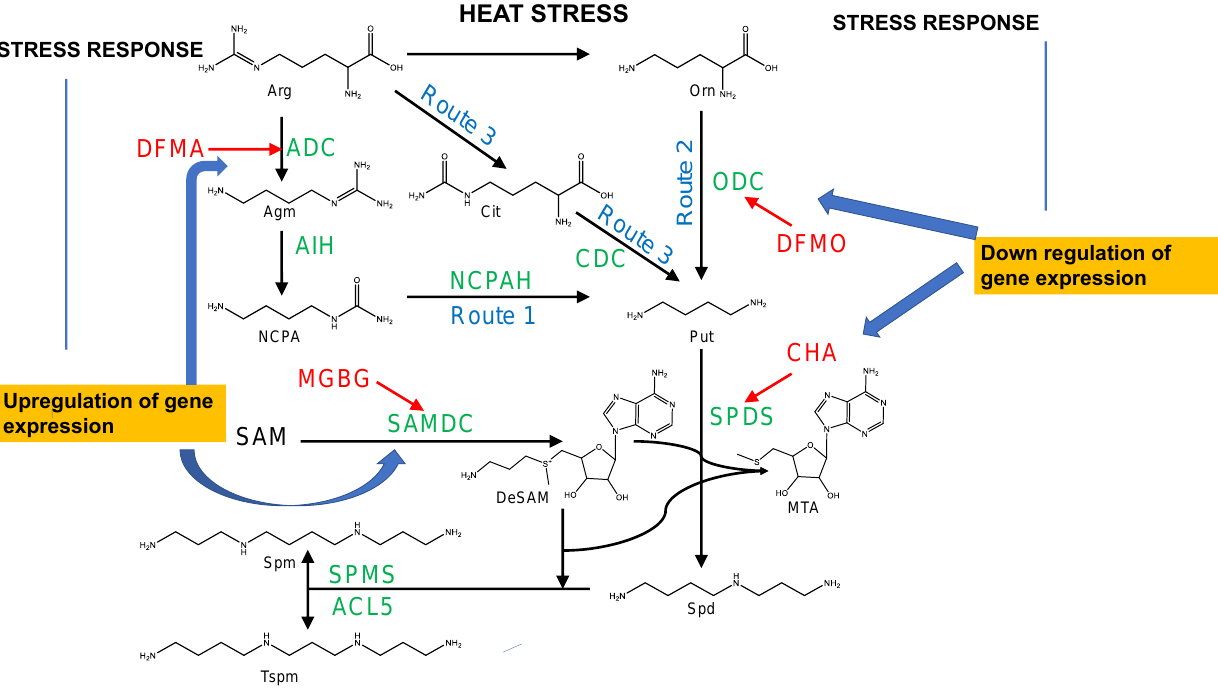
Figure 3. Abiotic Stress in plants affects the polyamine pathway at the transcriptional and transla- tional level. PAs such as putrescine (Put), spermidine (Spd), spermine (Spm) and thermospermine (Tspm) are formed either from arginine (arg) or ornithine (orn) by three different routes [39]. The pathway, initiated by arginine decarboxylase (ADC), leads to the formation of agmatine (Agm), which is converted by agmatine iminohydrolase (AIH) to N-carbamoylputrescine (NCP). NCP is hydrolized by N-carbamoylputrescine hydrolase (NCPH) to Put (Route1). Arg can be converted to Orn by arginase (Route 2) or to Citrulline (Cit) (Route 3), which is decarboxylated further by citrul- line decarboxylase (CDC) to putrescine. Important inhibitors of the pathway are DL-alpha-difluo- romethylarginine (DFMA), alpha-difluoromethylornithine (DFMO), methylglyoxalbisguanylhy- drazone (MGBG), and cyclohexylamine (CHA). After heat shock, or under abiotic stress, plants react with stress responses that can lead to up- or down regulation of gene expression (left and right panel of Figure 3). In Lycopersicon esculentum, ADC, SAMDC and ODC1 are the most upregulated genes, while SPDS is downregulated.